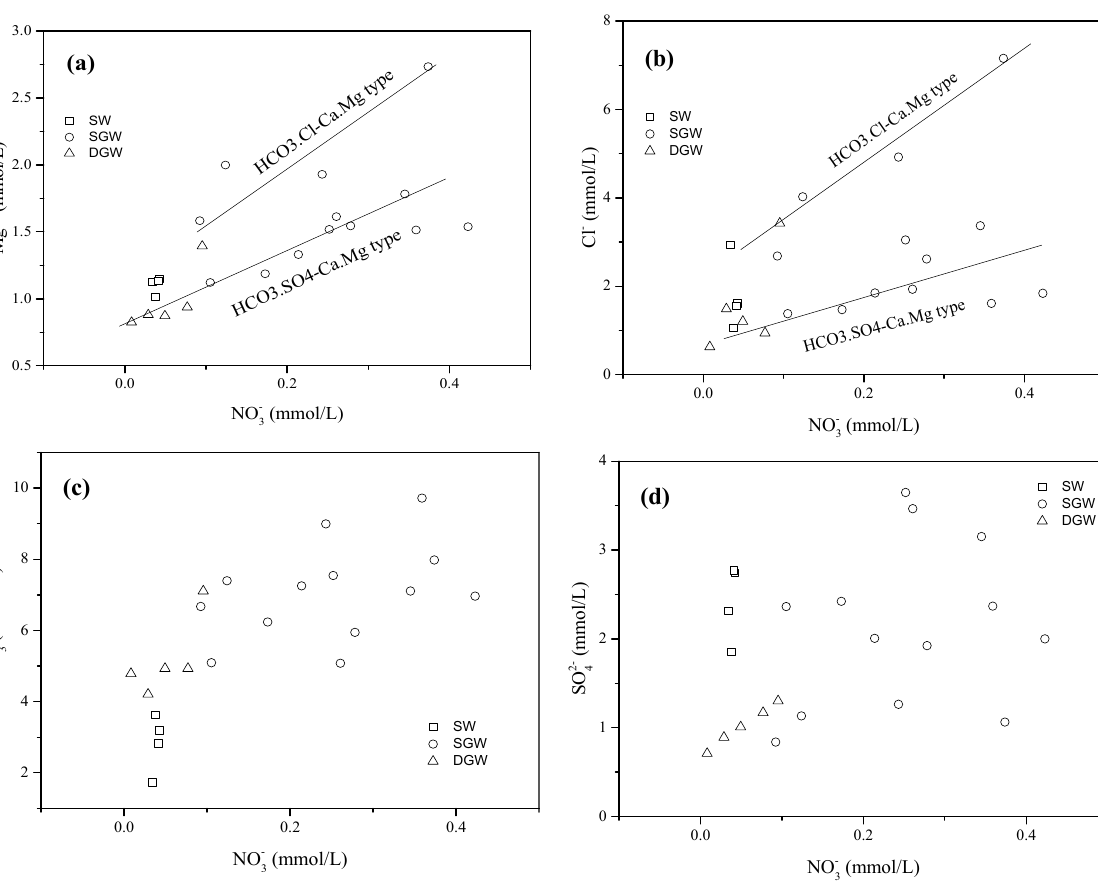
Figure 4. Relationships between ion concentrations of the surface water and groundwater, including ( a ) Ca 2+ vs. HCO (cid:2871)(cid:2879) ; ( b ) Ca 2+ +Mg 2+ vs. HCO (cid:2871)(cid:2879) ; ( c ). Ca 2+ vs. SO (cid:2872)(cid:2870)(cid:2879) ; ( d ) Na + vs. SO (cid:2872)(cid:2870)(cid:2879) ; ( e ) Mg 2+ vs. Cl − ; and ( f ) Na + vs. Cl − . (SW: Surface water; SGW: Shallow groundwater; DGW: Deep groundwater).